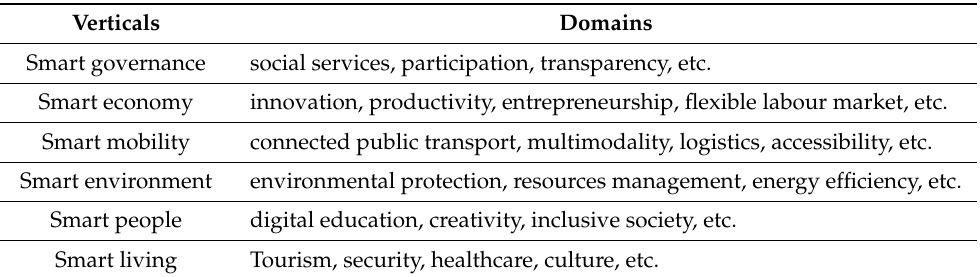
Table 2. Verticals and domains of smart cities.